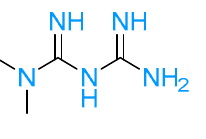
Figure 3. Metformin structure.